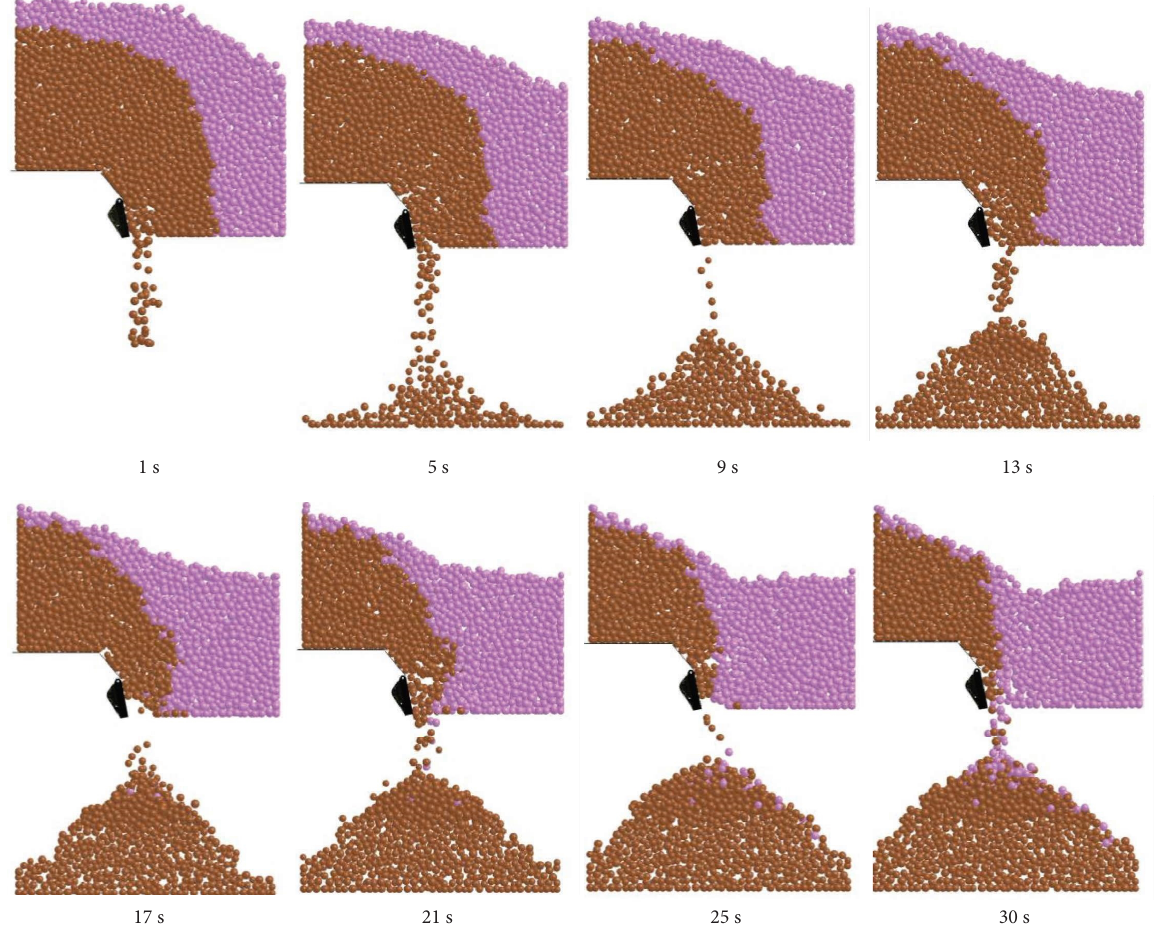
Figure 24: Te coal-caving process when the mining and caving ratio is 1:2.67.